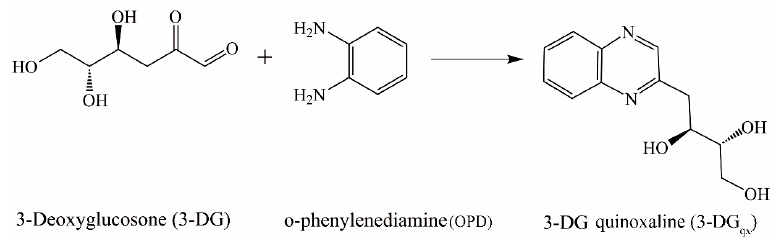
Figure 1. Derivatization of 3-deoxyglucosone (3-DG) by o -phenylenediamine (OPD).